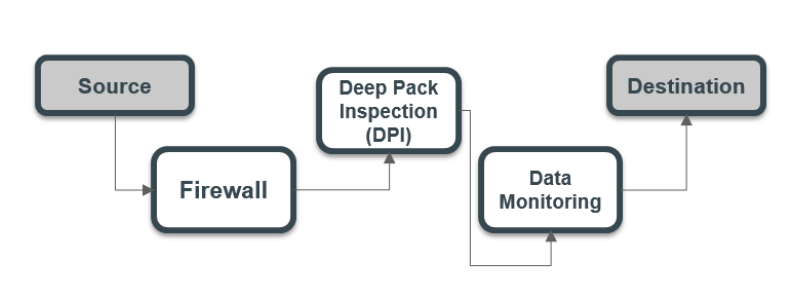
Figure 1. Service chain